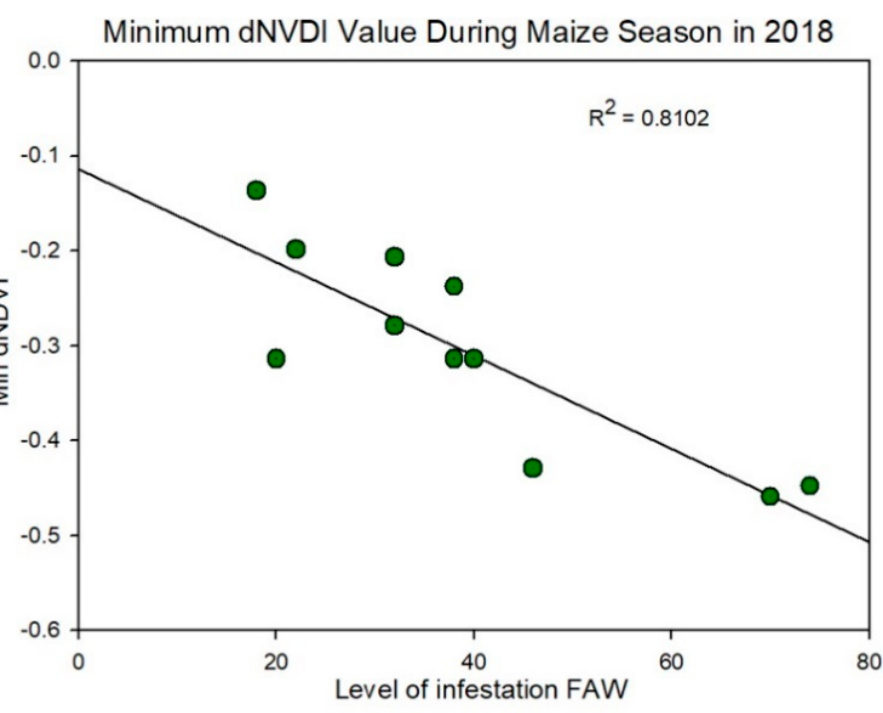
Figure 7. Relation between the minimum value from the entire growth season of the first-derivative NDVI time series against the level of infestation of the FAW (0-100) in the maize field collected by the FAMEWS app.